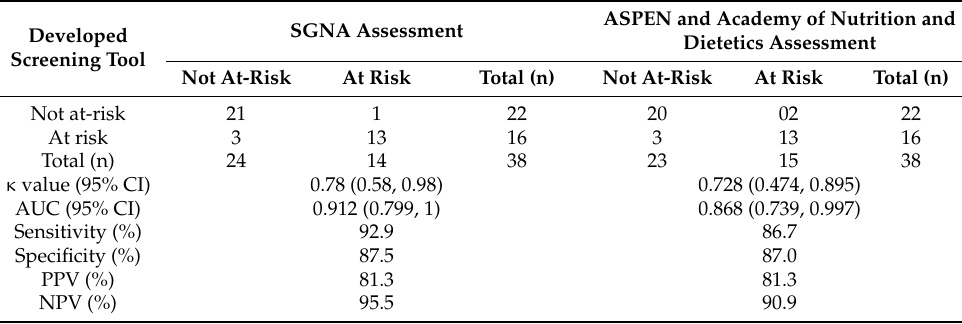
Table 3. Comparison of the developed screening tool with the other published criteria. SGNA Developed Screening Tool